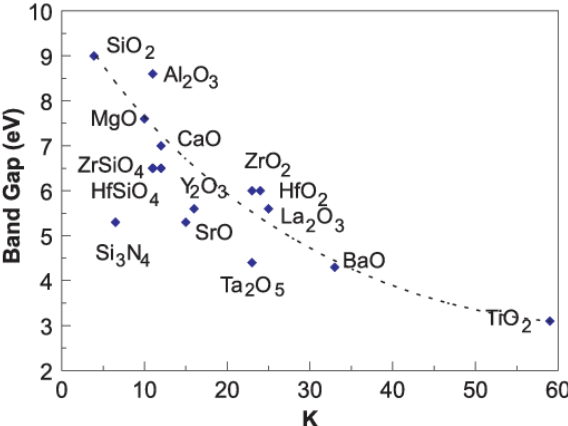
Figure 7. Dielectric permittivity of inorganic materials. Bandgap as a function of the dielectric permittivity for different inorganic dielectrics, mainly oxides. Reproduced from [90], © (2004) EDP Sciences). dielectric structure composed of SiN x /SiO 2 (200 nm/400 nm) (SiN x having a dielectric con-